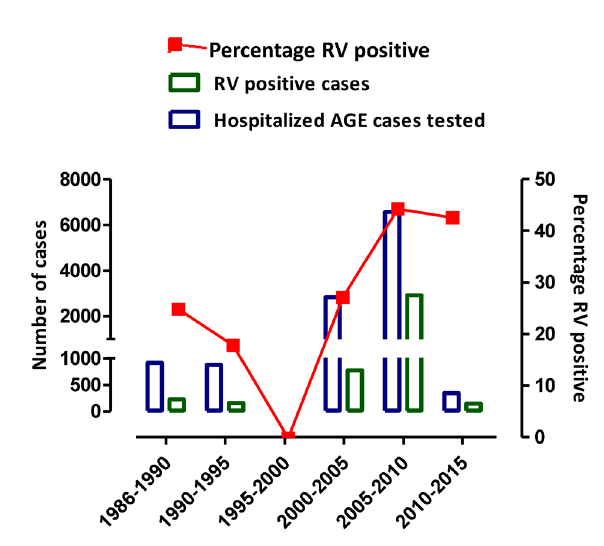
Figure 1. Number of Hospitalized AGE Cases (Blue Bars) and Hospitalized AGE Cases Testing Rotavirus-Positive (Green Bars) From 1986 to 2015. The red line indicates the percentage of rotavirus-positive